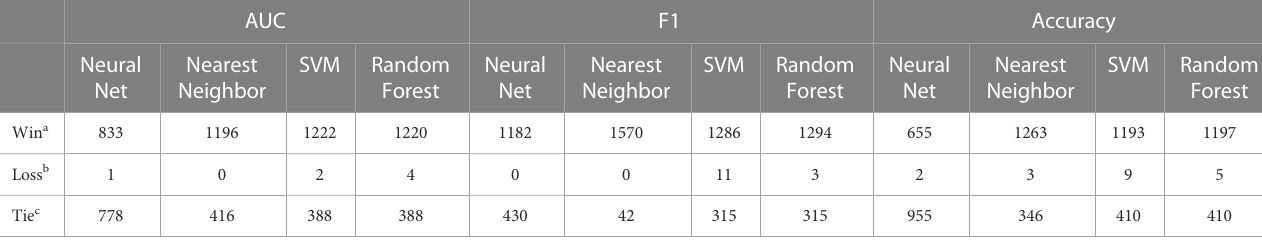
TABLE 1 Performance comparison of HiRAND and competitive methods.